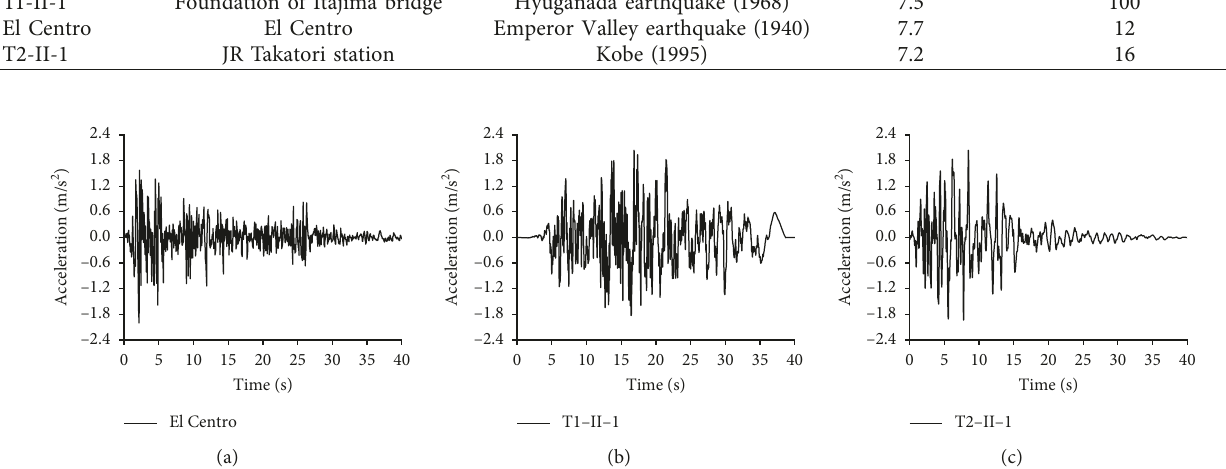
Figure 3: Time-history of earthquakes (reproduced from the study of Huang et al. [20], under the Creative Commons Attribution License/ public domain).